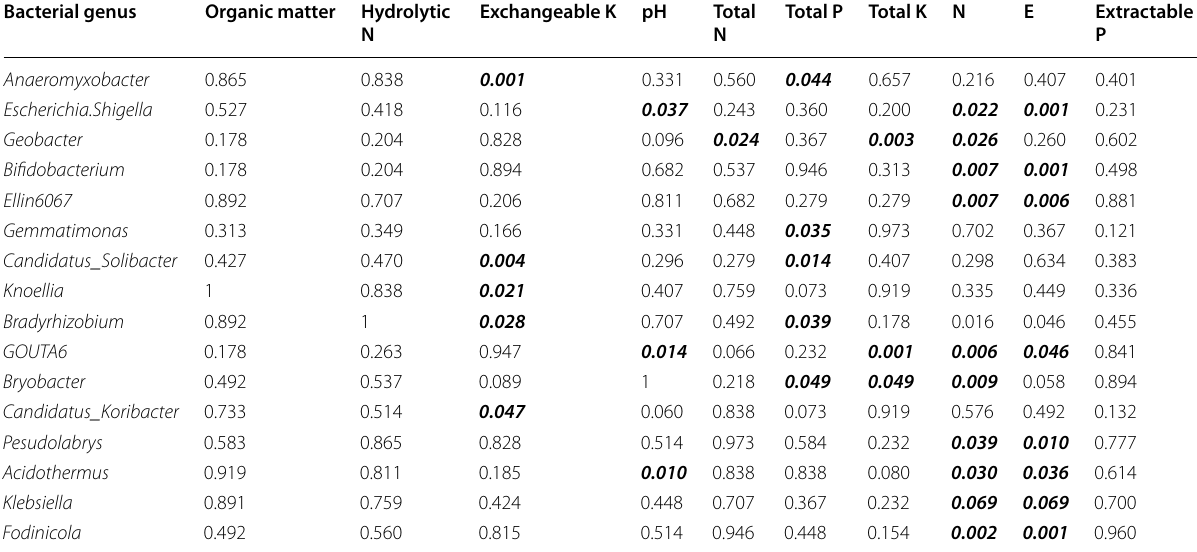
N: Northern latitude; E: East longitude; Boldface: significance; Italic boldface: top effect on soil chemical properties and soil sites